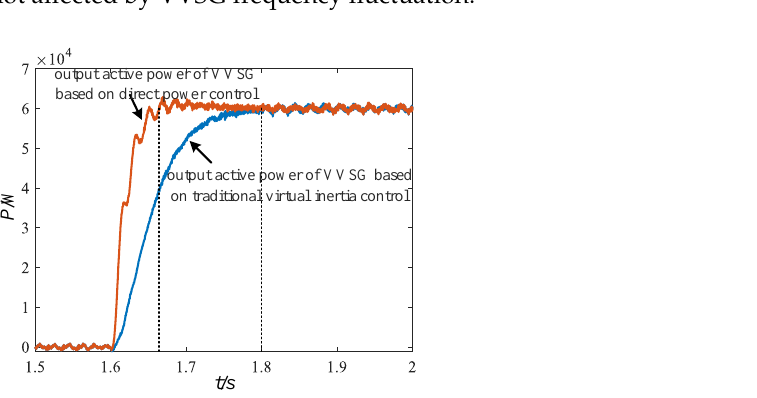
Figure 11. The output active power waveforms of VVSG connected to a strong utility grid.